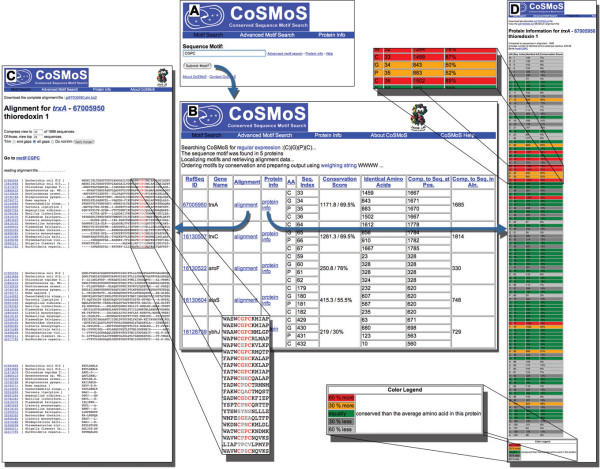
The CoSMoS website. (A) The Motif Search web tool can be used to search for small sequence motifs. (B) The result is displayed in a table containing information about the conservation of the amino acids in the motif and links to the alignment (shown here with the "trim all gaps" option) (C) and the CoSMoS gene info page (D).